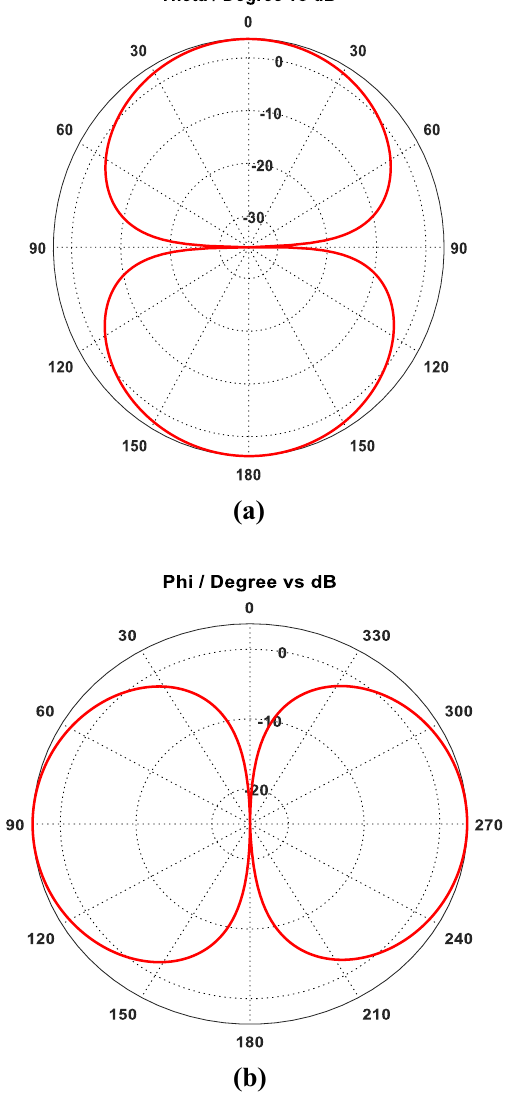
Fig. 7 Radiation pattern a E plane b H plane